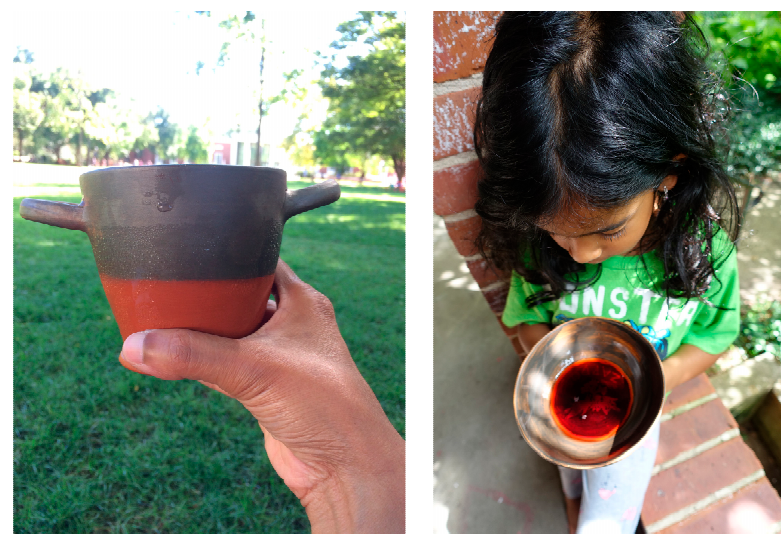
Figure 17. Left: “Sweating” skyphos filled with water. Right: Changes in the color of the vessel in Figure 17. ( Left ) “Sweating” skyphos filled with water. ( Right ) Changes in the color of the vessel in sunlight and when filled with cherry juice. sunlight and when filled with cherry